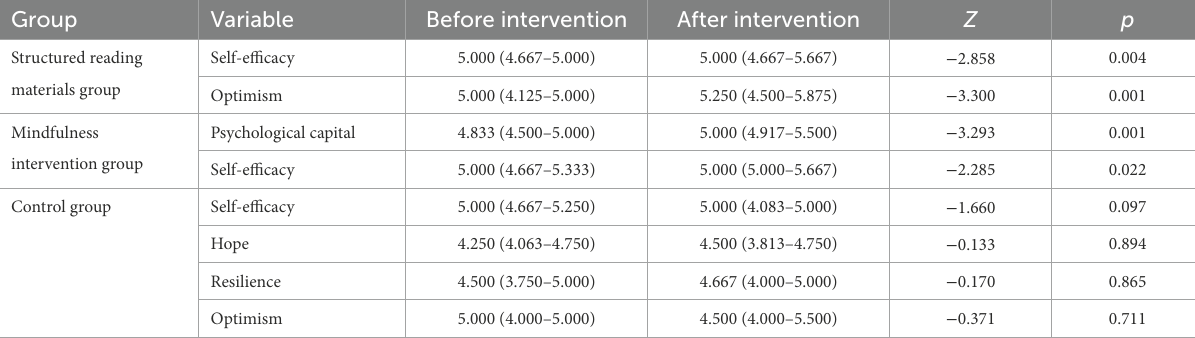
TABLE 4 Wilcoxon test (P 25 , P 50 , P 75